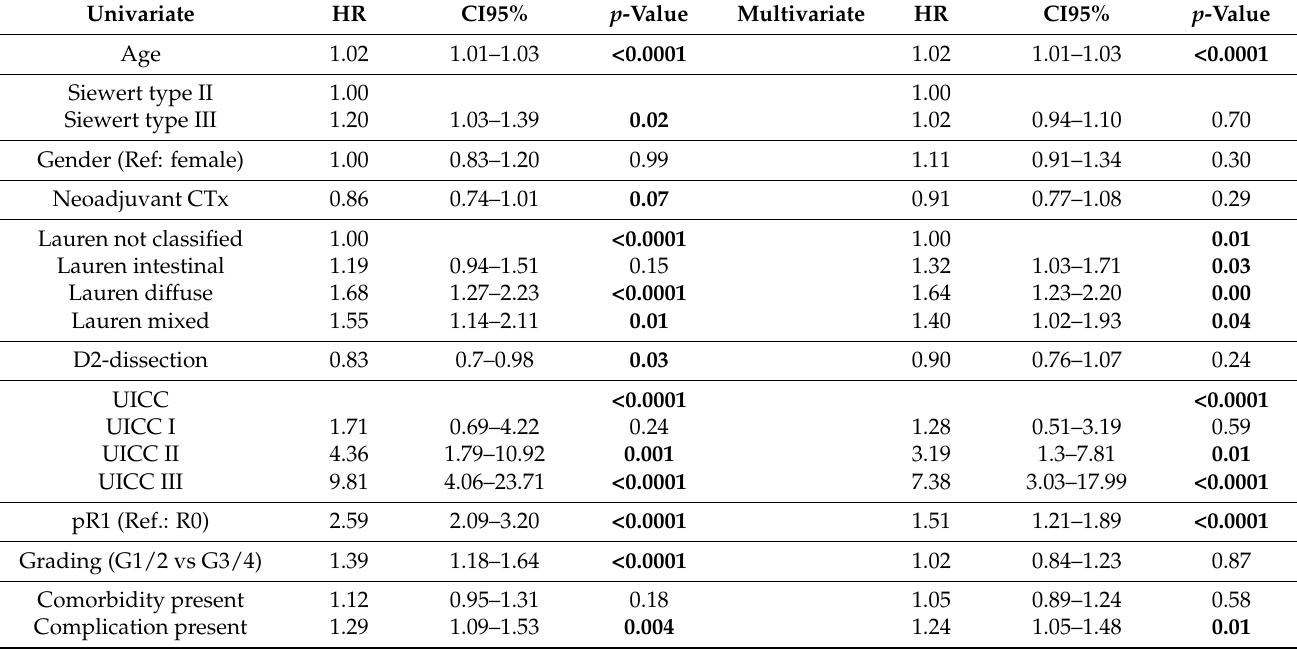
Table 2. Univariate and multivariate regression analysis for